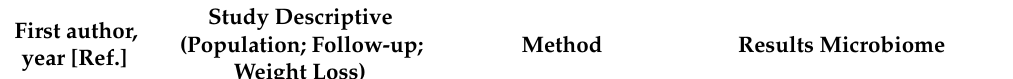
Table 2. Bariatric surgery, gut microbiome and